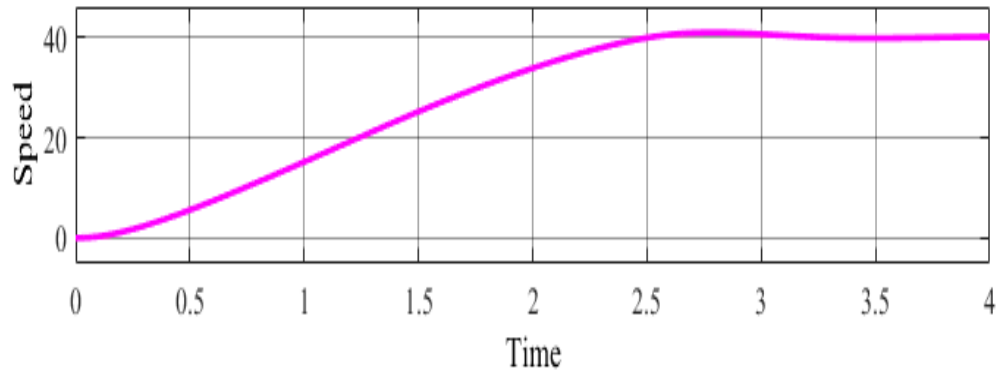
Figure 9. Speed response without optimization.